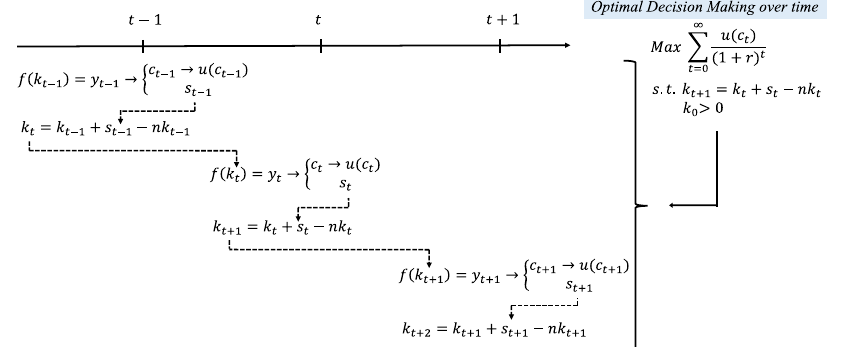
origin at the Modi fi ed Golden Rule level. Since the Modi fi ed